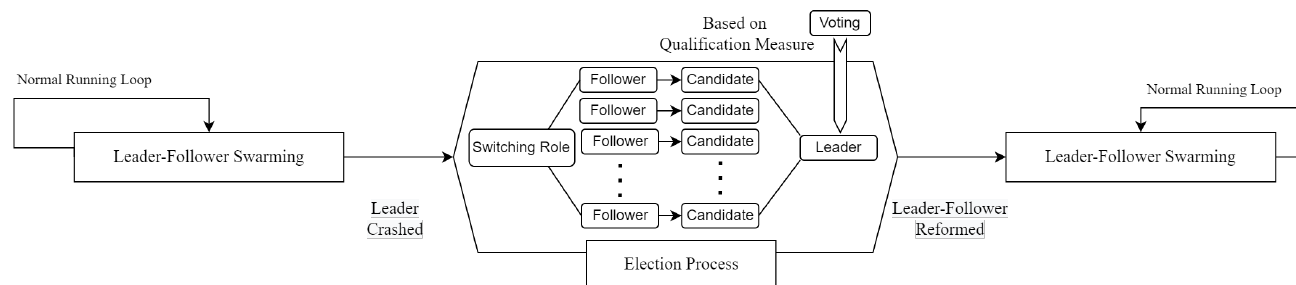
Figure 2. A comprehensive leader election process